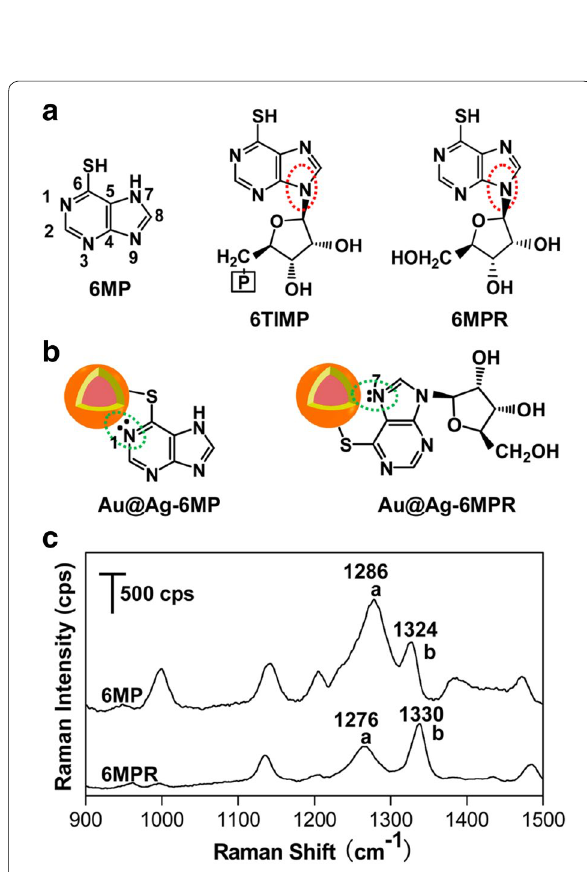
Fig. 14 a Chemical structures of 6MP and its riboside derivatives 6TIMP and 6MPR (N9 positions were indicated with the red circles). b The different adsorption behaviors of 6MP and 6MPR on the surface of Au@Ag NPs. c SERS spectra of 6MP and 6MPR (1 colloid of Au@Ag NPs. All the Raman spectra were recorded with 532 nm laser (Reprinted with permission from [124]. Copyright @ 2014 American Chemical